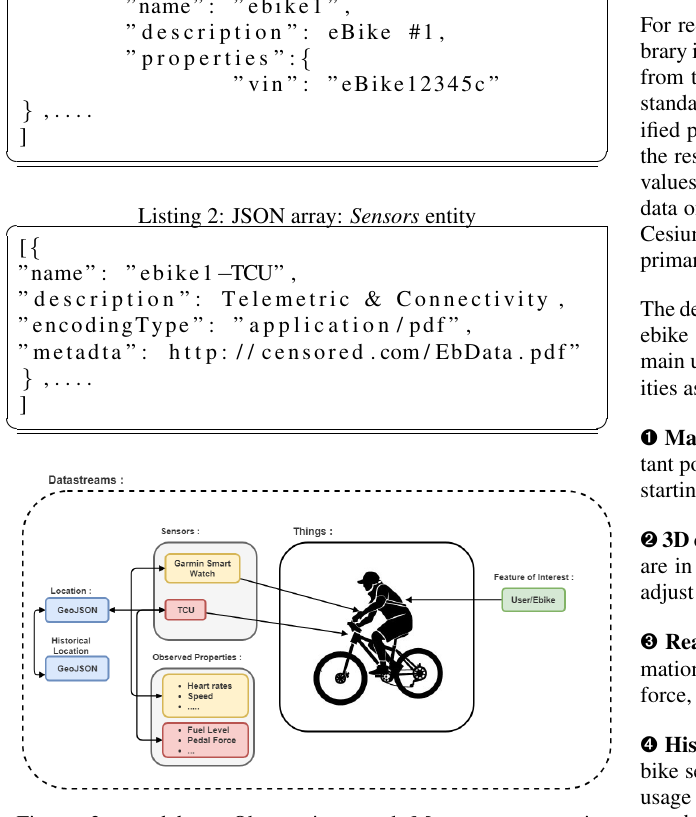
Figure 3: pedelec : Observations and Measurements enti- ties (FreeVectors.net,